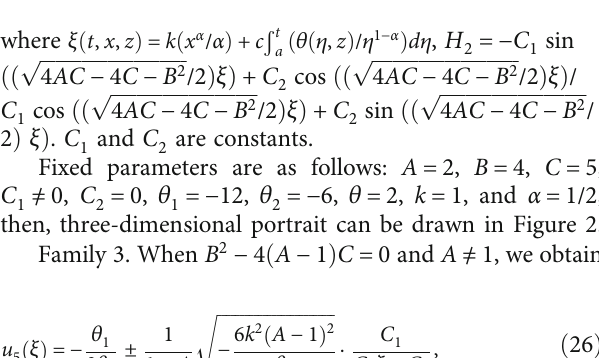
ð t , x Þ of Equation (26) for di ff erential 5